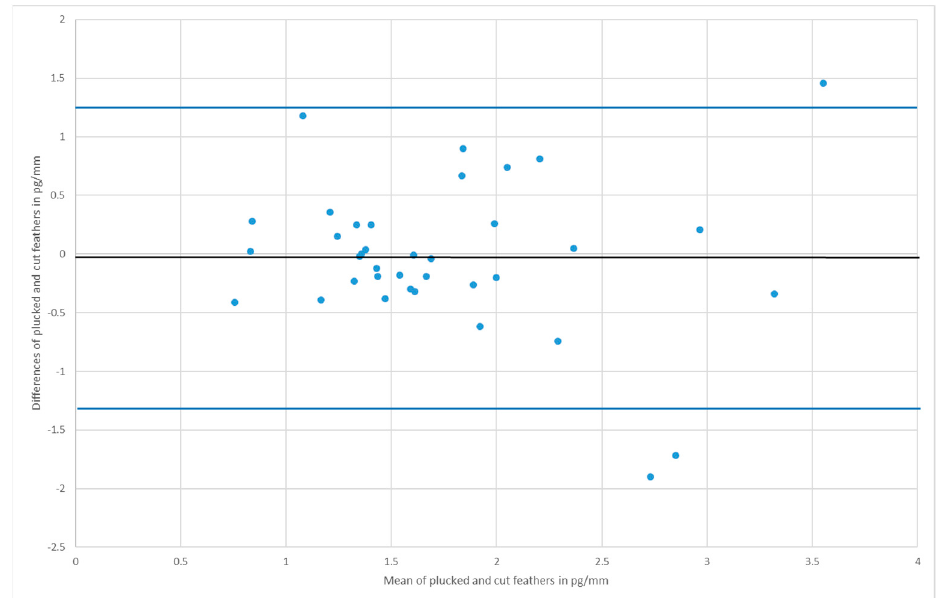
Figure 4. Bland–Altman plot of Anas ; the residual plot displays the differences (y-axis) against the means of values (x-axis). The blue horizontal lines represent the mean difference ± 2 SD (mean = − 0.03, SD = 0.65).